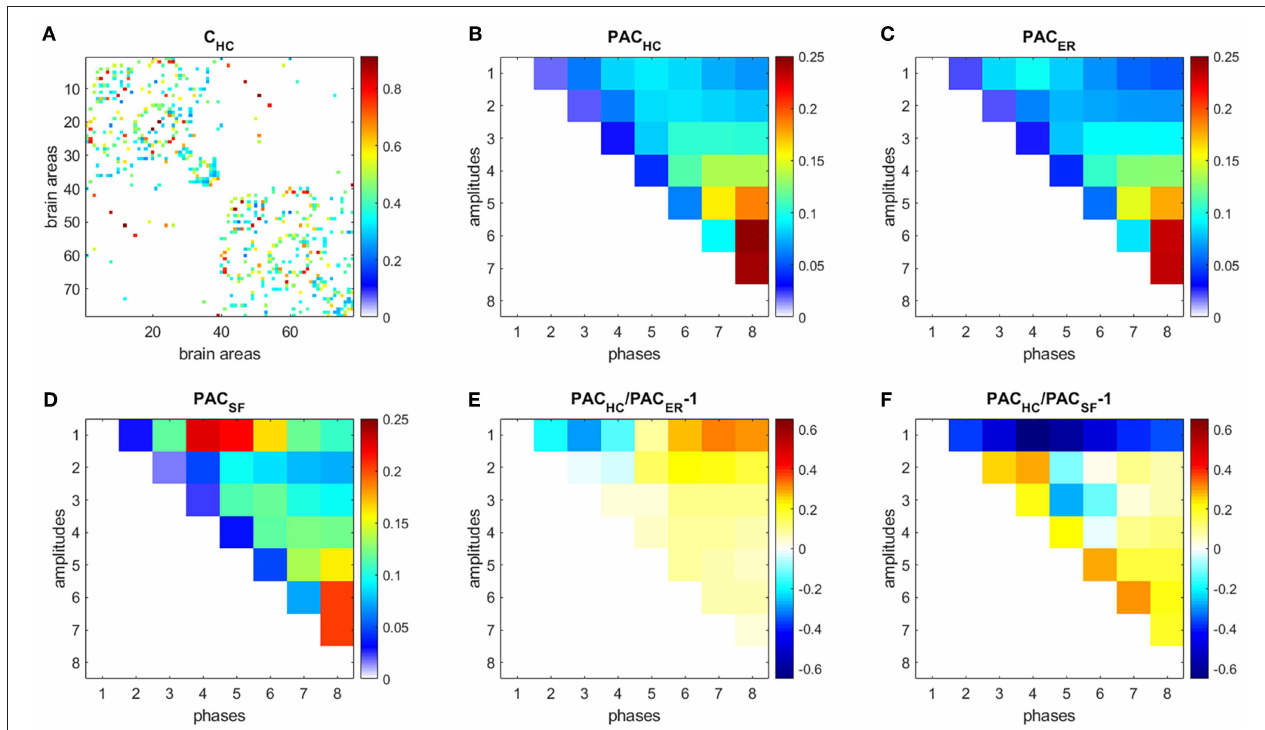
FIGURE 5 | PAC in HC. (A) Connectivity matrix. (B) PAC averaged over 44 HC subjects. (C) Average PAC generated from 500 equivalent ER networks. (D) Average PAC generated from 500 equivalent SF networks. (E) Comparison of PAC from HC and PAC generated from equivalent ER networks. (F) Comparison of PAC from HC and PAC generated from equivalent SF